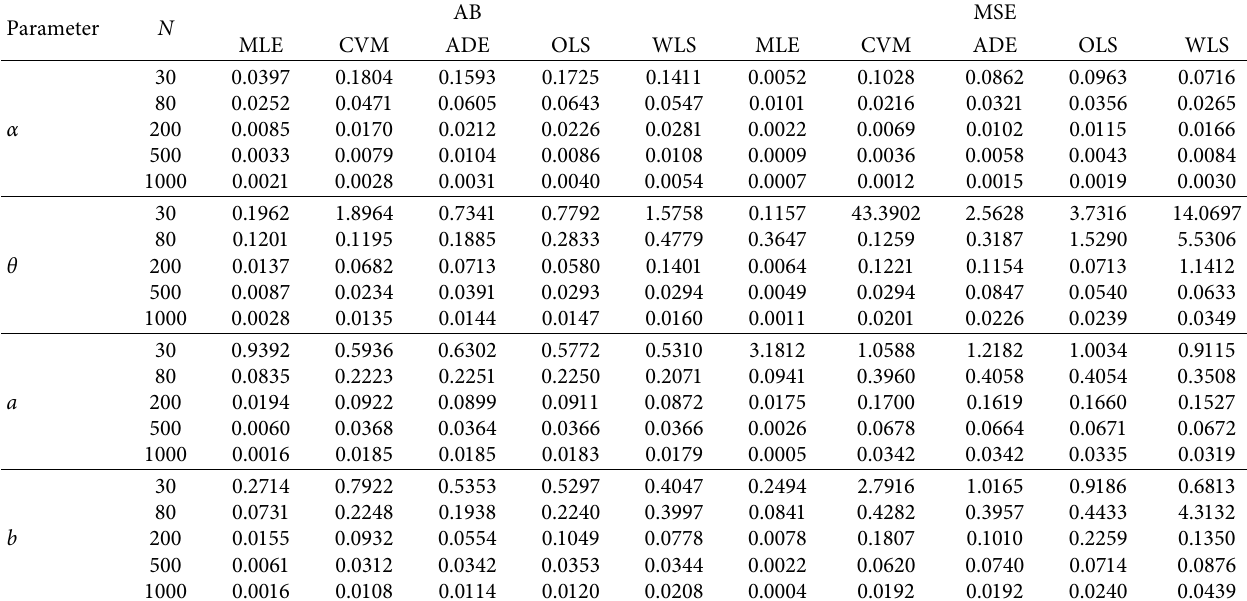
Table 4: Results of simulations for ( α , θ ,a,b ) � ( 0 . 3 , 0 . 6 , 1 . 9 , 2 . 5 )